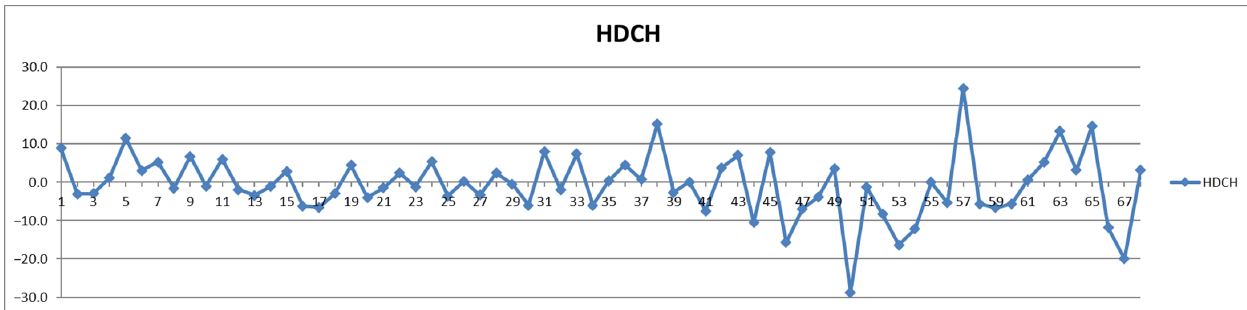
and fasting concentrations as percentage relative to fasting concentration. Figure 15. The food intake effect on HDL cholesterol (HDCH) as difference between postprandial